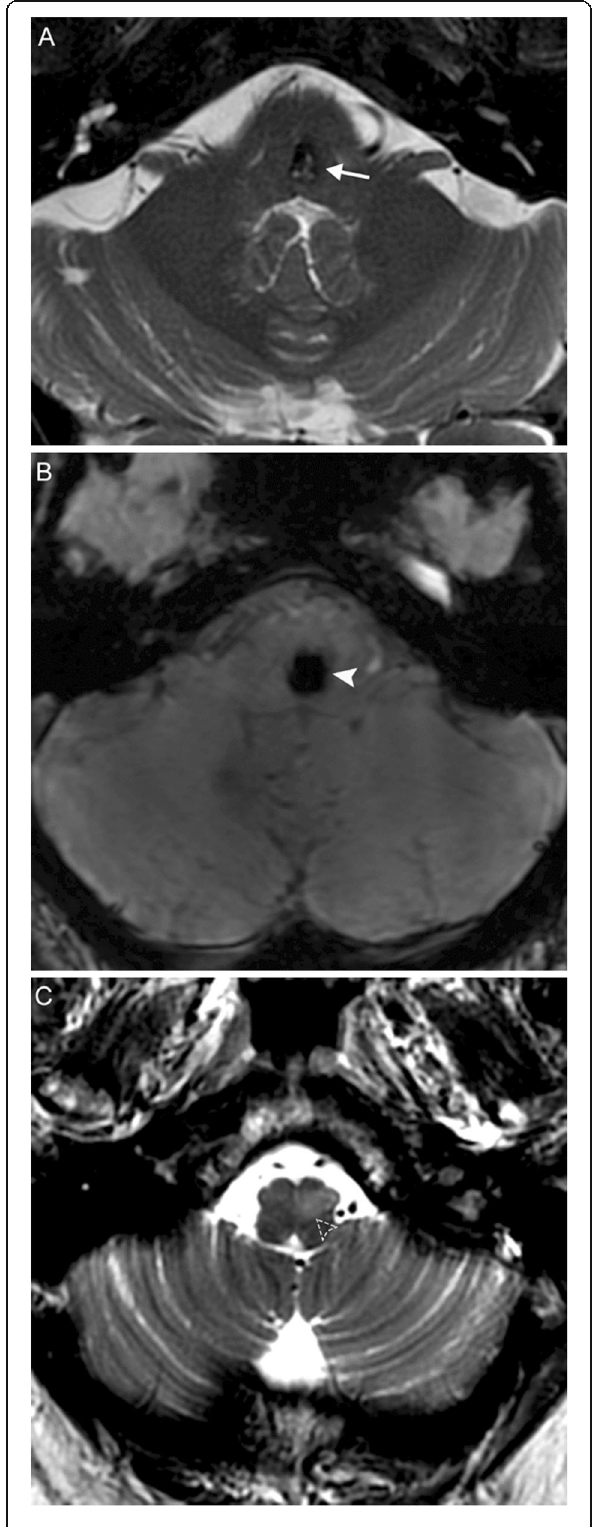
Fig. 10 Hypertrophic olivary degeneration. A 69-year-old man with history of hypertension presenting with new onset palatal myoclonus, hoarse voice, and ataxia. Axial T2 ( a ) and susceptibility- weighted ( b ) MR images reveal a lesion at the left parasagittal pontomedullary junction at the level of the facial colliculus demonstrating bubbly high T2 signal internally surrounded by a rim of low T2 signal intensity (arrow) and associated blooming (solid arrowhead), compatible with a cavernous malformation. Thin section axial T2 image ( c ) reveals hyperintensity and expansion of the left inferior olivary nucleus (dashed arrowhead), consistent with hypertrophic olivary degeneration. Lesions involving the dento- rubro-olivary tract (such as this cavernous malformation) can lead to hypertrophic olivary